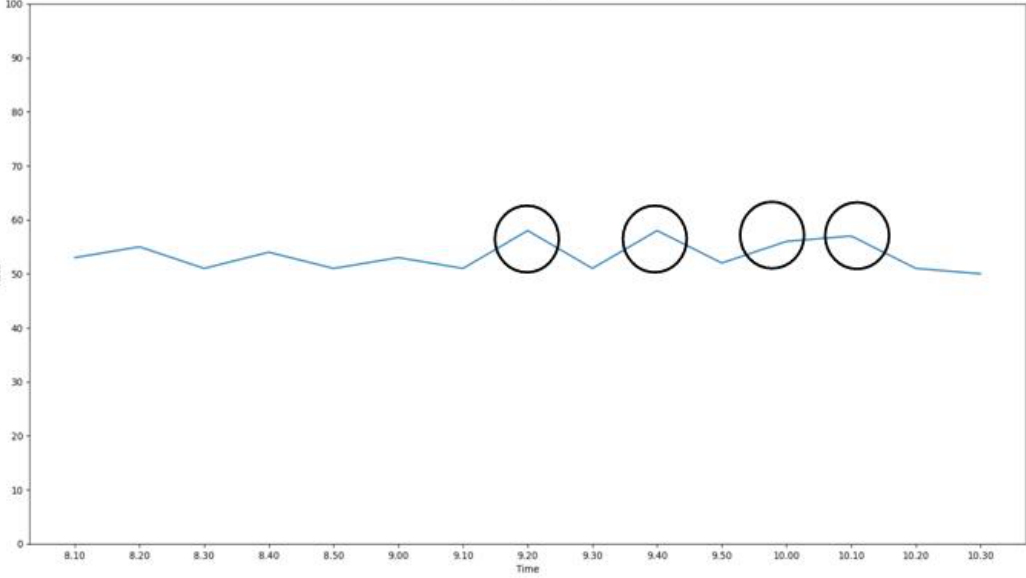
Fig.3 Student #2 heart rate measurement during Class A at 8.00 am.